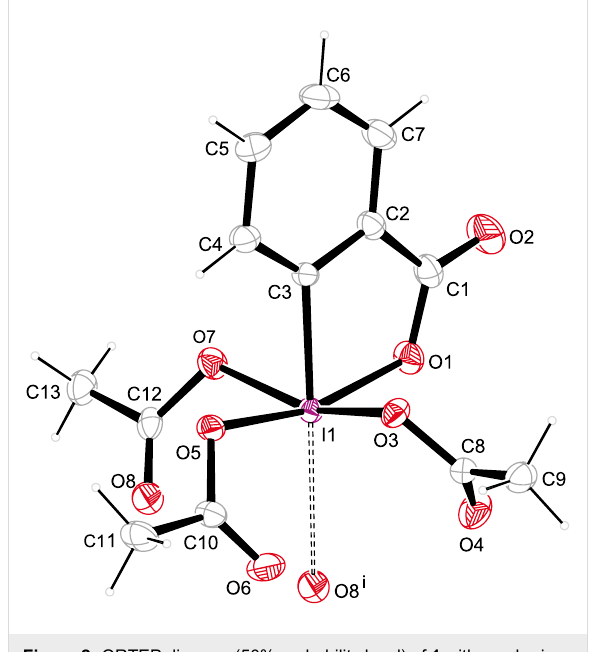
Figure 2: ORTEP diagram (50% probability level) of 1 with numbering scheme.